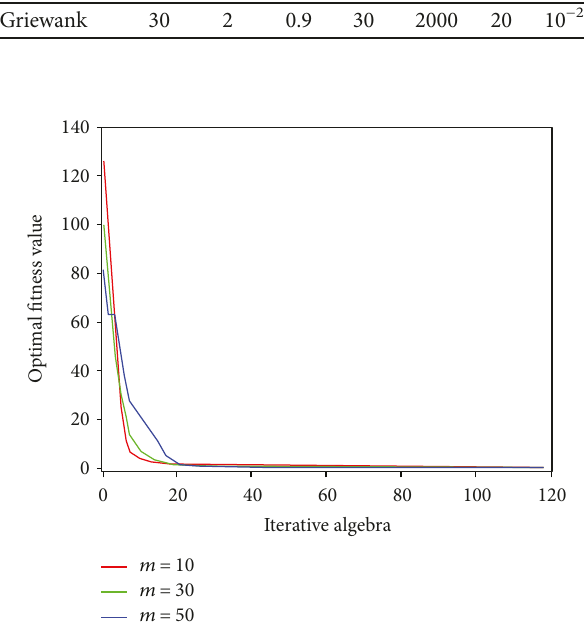
Figure 9: The e ff ect of population size algorithm